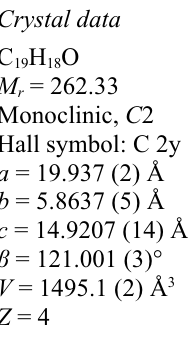
The packing figure ( PLATON : Spek, 2003) which shows the stacking of molecules in a unit cell. (1 E ,4 E